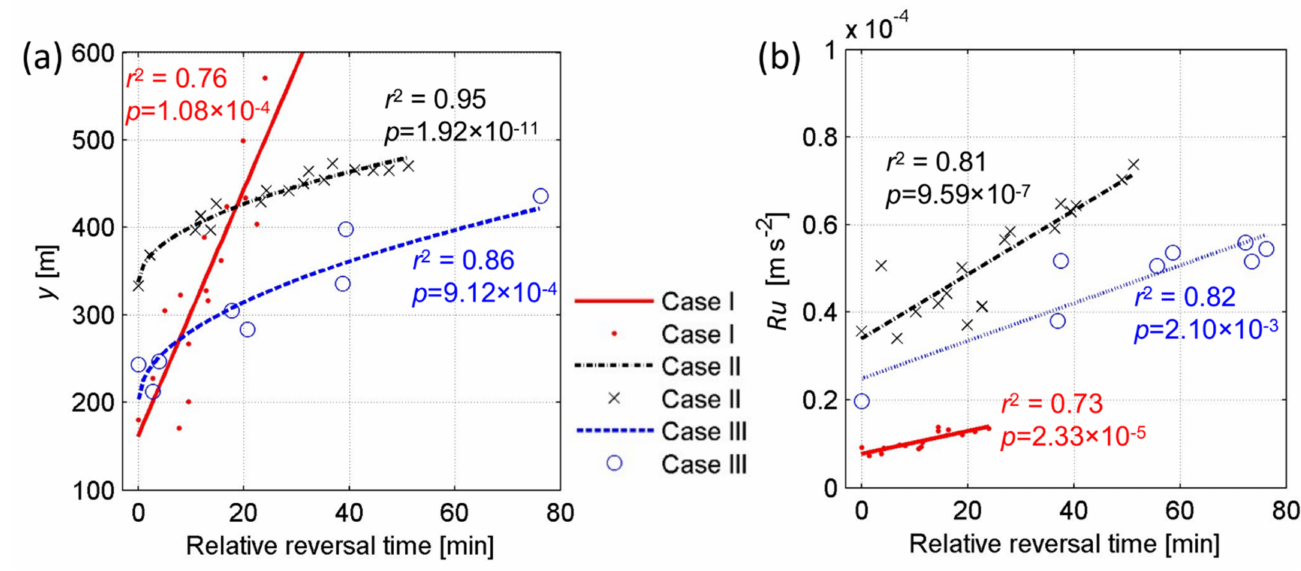
Figure 8. ( a ) Relative reversal time observed by sea surface drifter clusters versus cross-shore distance. Zero relative reversal time is defined as the earliest reversal time of each case. ( b ) Bottom drag term, Ru , versus the relative reversal time. Symbols and lines indicate the observations and least-squares fit results, respectively, for Case I (red), Case II (black), and Case III (blue). Squared cross-correlation, r 2 , and p -value results for each fit are shown on each